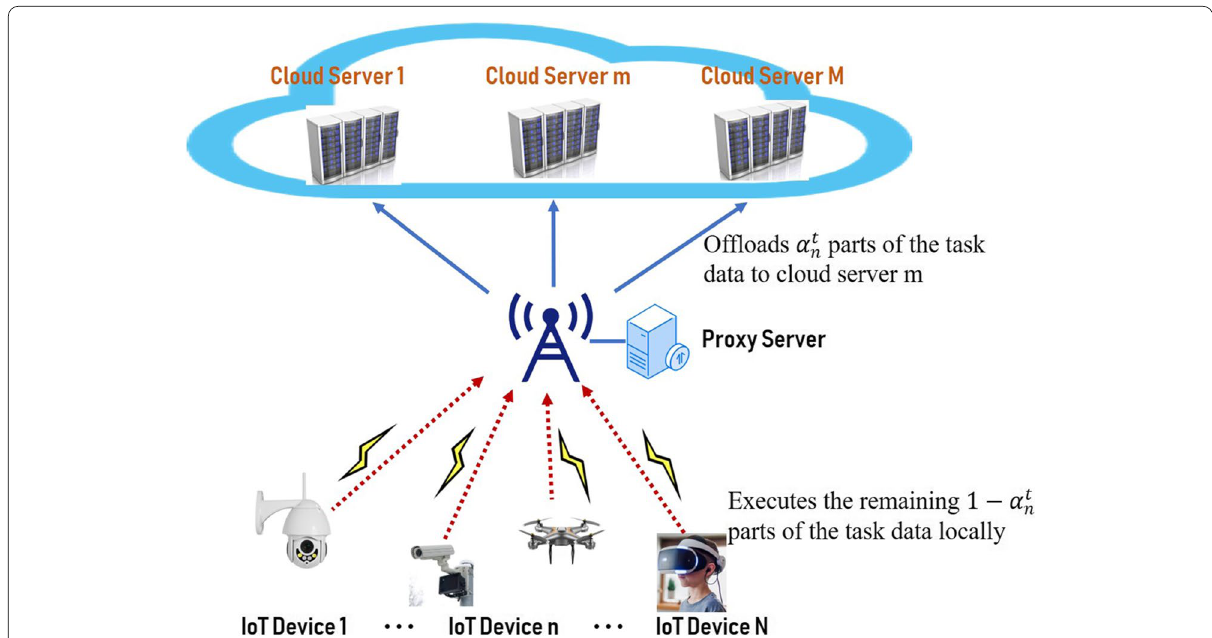
Fig. 1 An example multi-cloud computing system with task